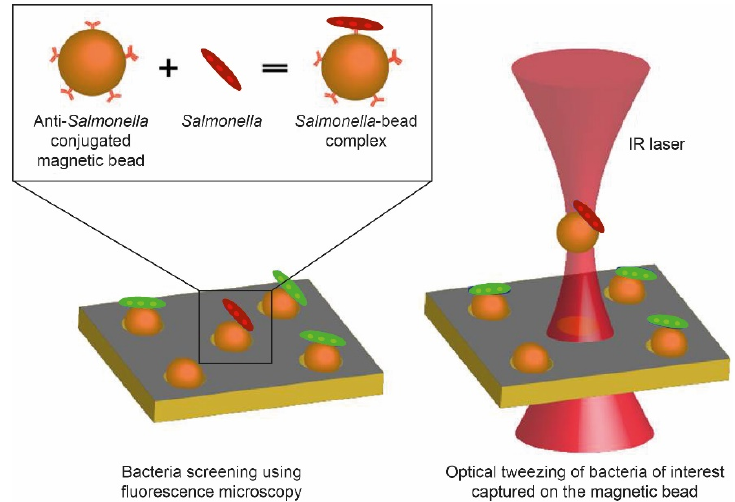
Figure 1. Salmonella bacteria bind to MBs conjugated with anti- Salmonella antibody, forming thereby Salmonella –bead complex, which is subsequently captured using infrared (IR) laser-based OT.